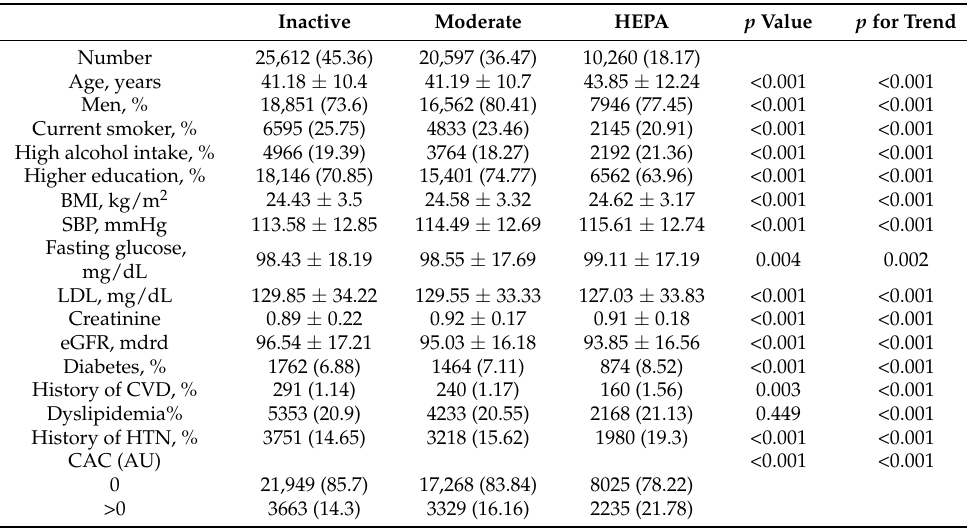
Table 1. Baseline characteristics of participants according to physical activity